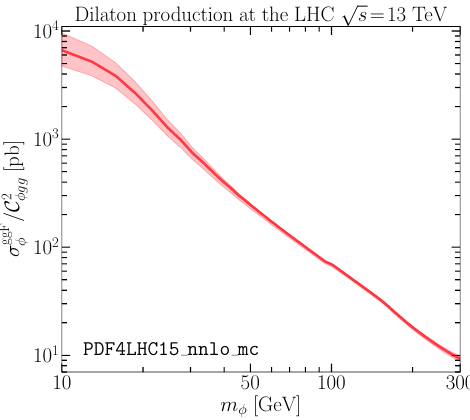
2 at the LHC with (cid:30)gg C